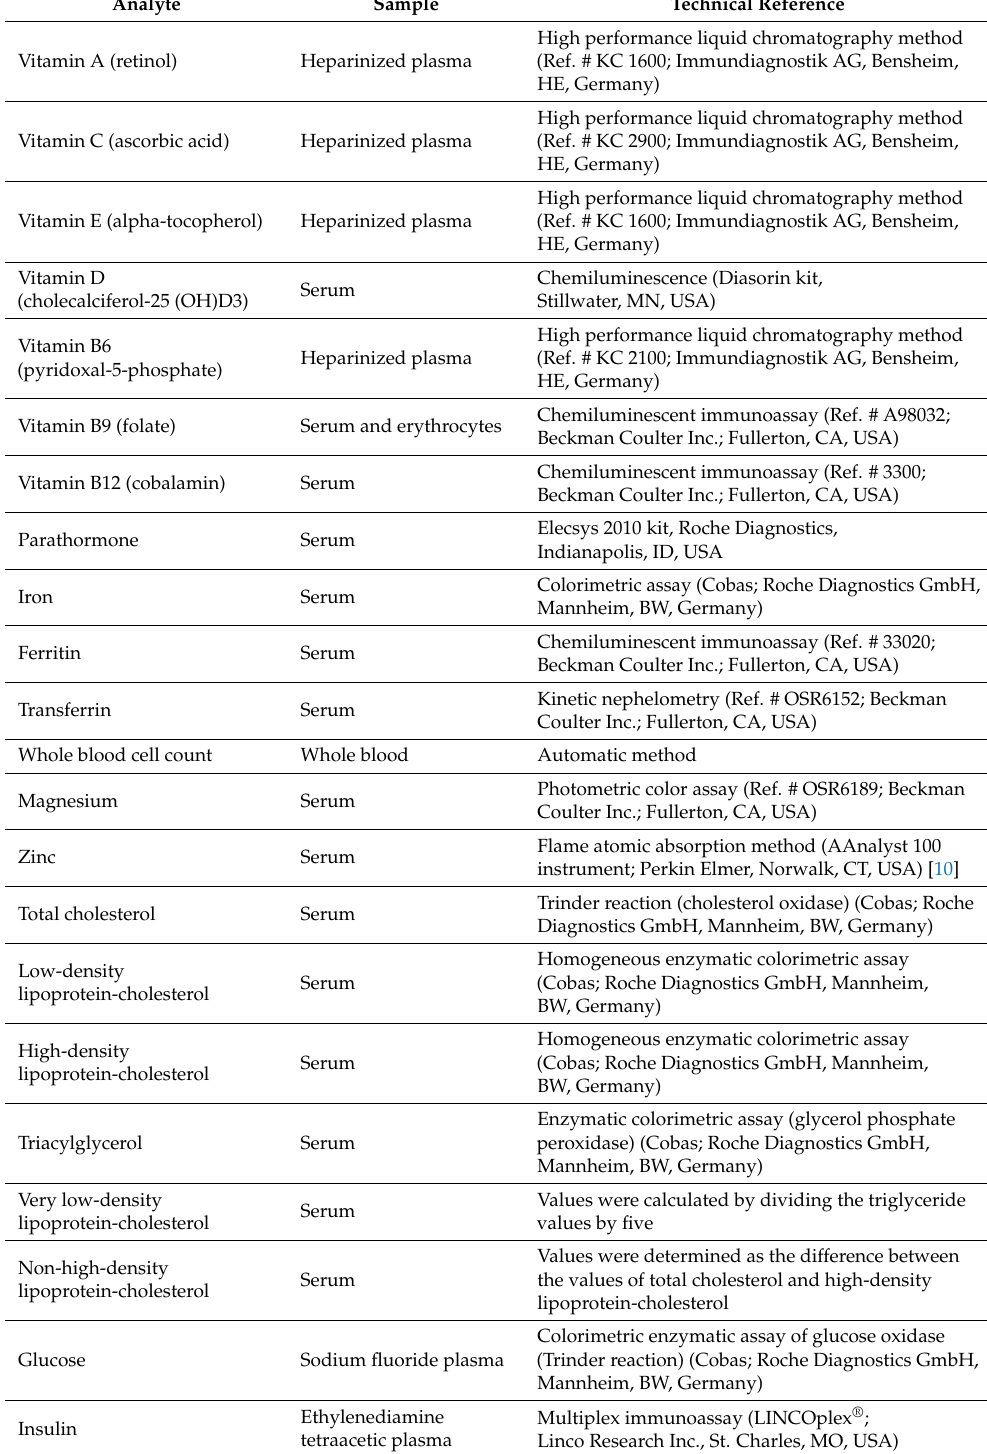
Table 1. Baseline laboratory measurements in the 2015 ISA-Capital. S ã o Paulo,